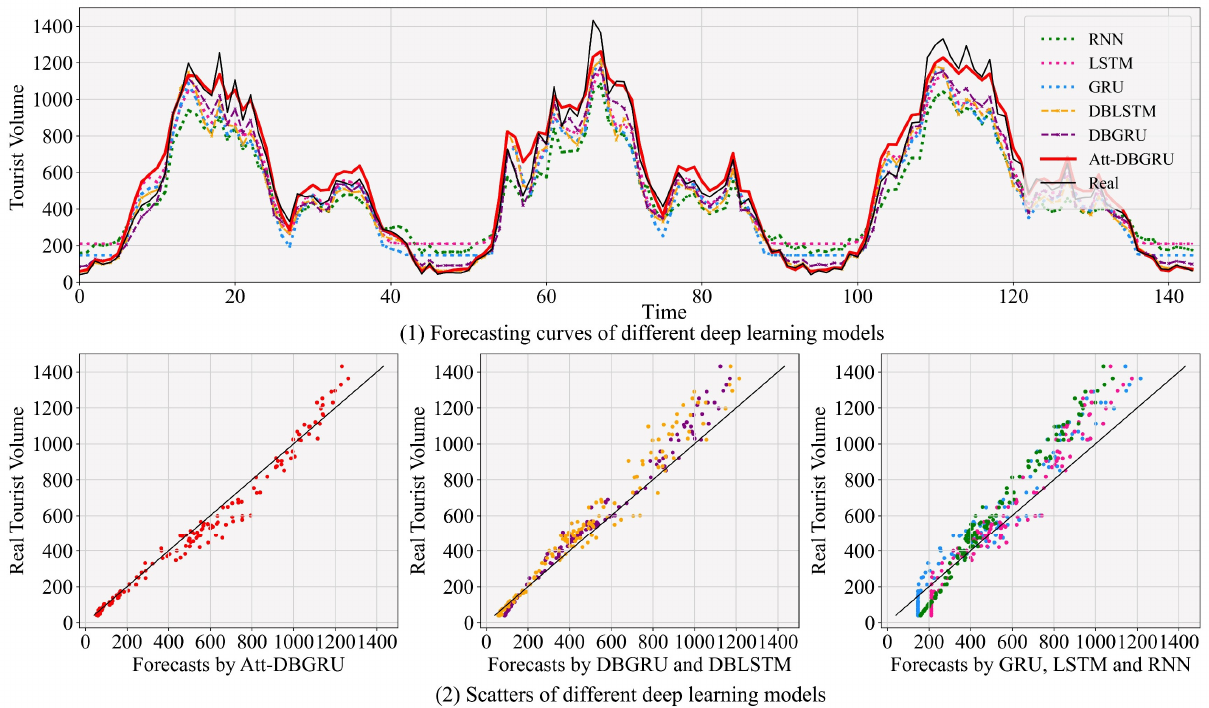
Figure 5. Real and forecasted tourist volume of the entire Taiyangdao Park.